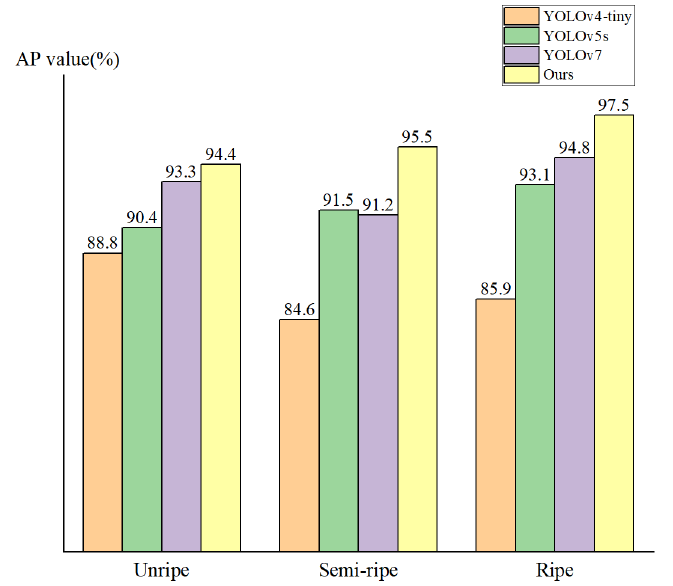
Figure 12. Comparison bar graphs of the AP of the four models for pineapple with different matur- ities.